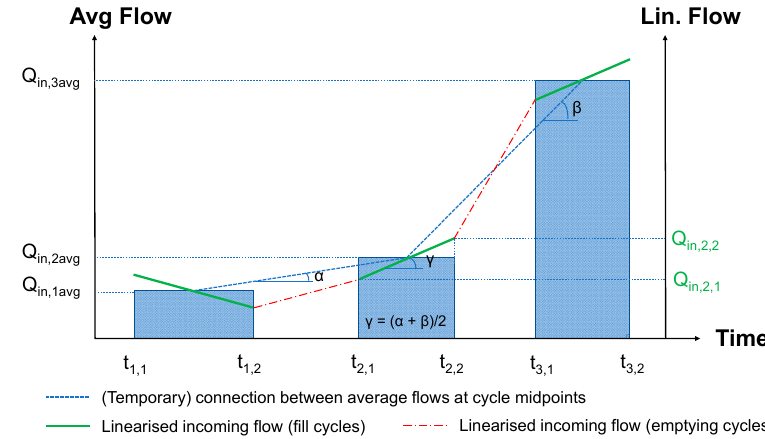
Figure 4. Linearisation of incoming flows.